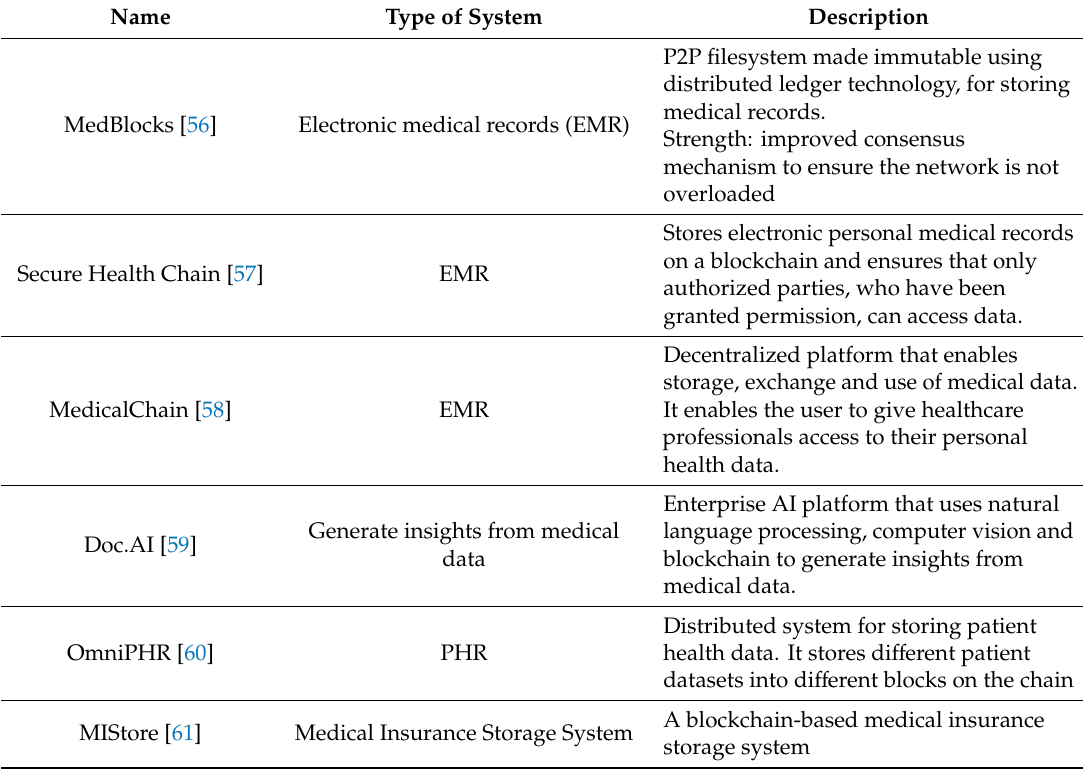
Table 2. Review of blockchain systems in